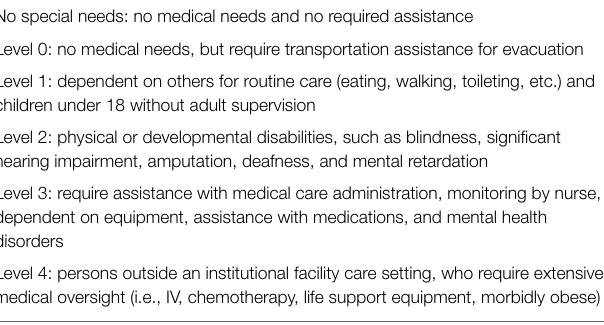
TABLE 1 | Level of medical special needs (MSN)